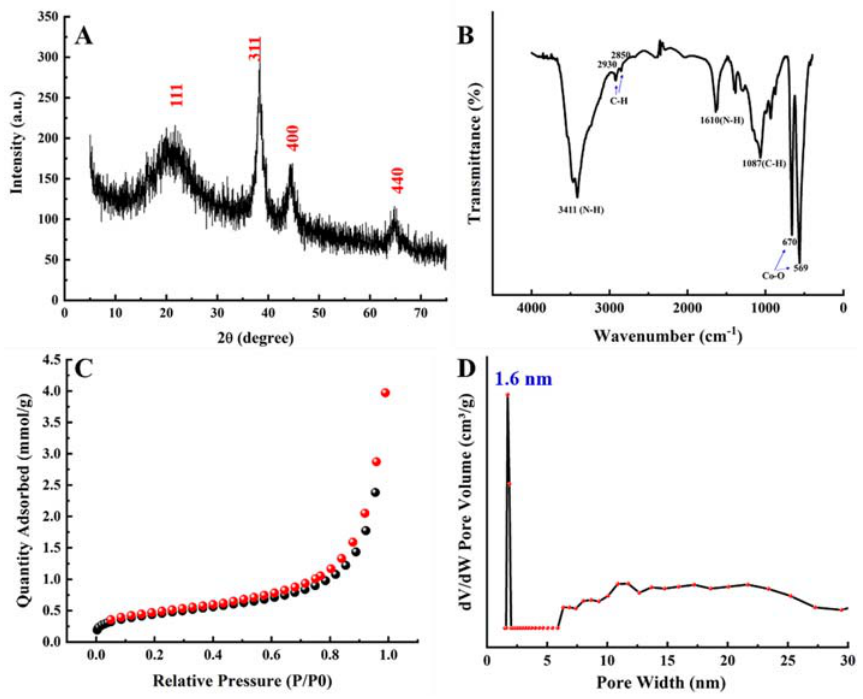
Figure 4. XRD patterns ( A ), FT - IR spectra ( B ), N 2 adsorption (black) and desorption (red) isotherms ( C ), and the corresponding pore size distribution curves ( D ) of Pt/Au NPs@Co 3 O 4.